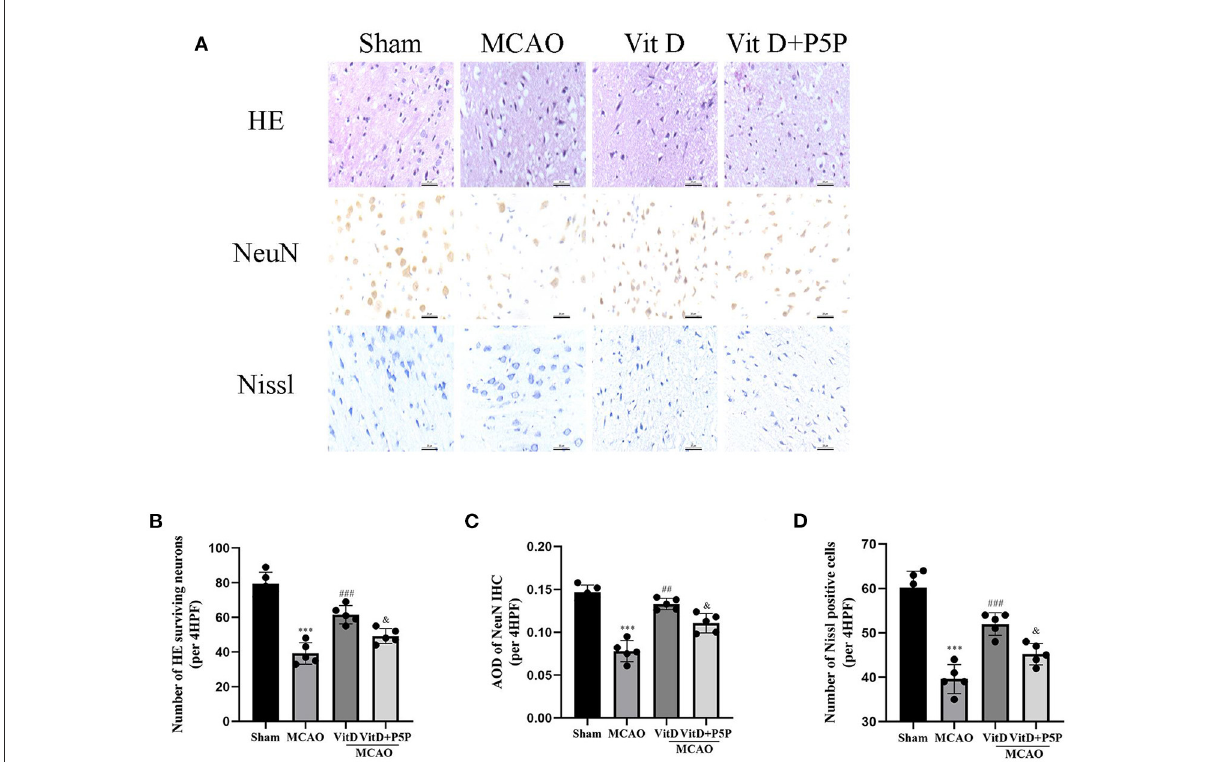
FIGURE3 HE, NeuN, and Nissl staining of cortical neurons of each group. (A) HE, NeuN, and Nissl staining procedures were conducted to observe the morphology and number of the cerebral cortical neurons (400 × ). (B–D) Quantification of the HE, NeuN, and Nissl staining. All values are the mean ± SEM. *** P < 0.001 (vs. Sham), ## P < 0.01, ### P < 0.001 (vs. MCAO), & P < 0.05 (vs. VitD), n = 5. P5P, antagonist of VDR; Vit D,